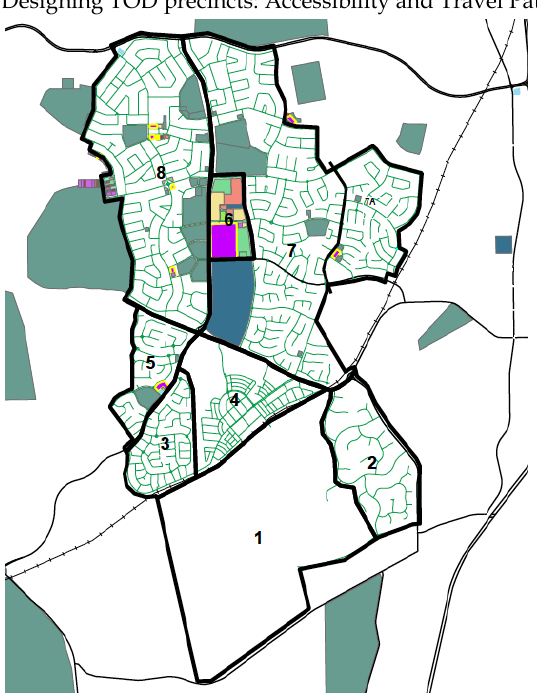
Figure 2. Local accessibility maps including roads and land use Note: Magenta denotes offices, yellow and orange various types of retail, brown manufacturing, and green public